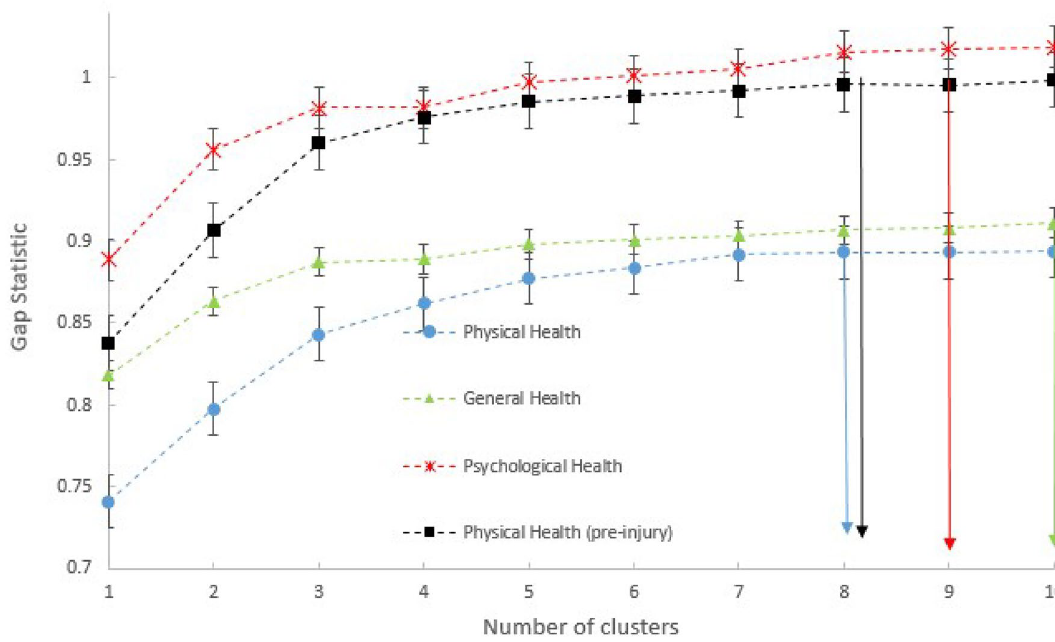
Figure 2. Optimum number of clusters with kml3d for the four different cases of variables and k-means.